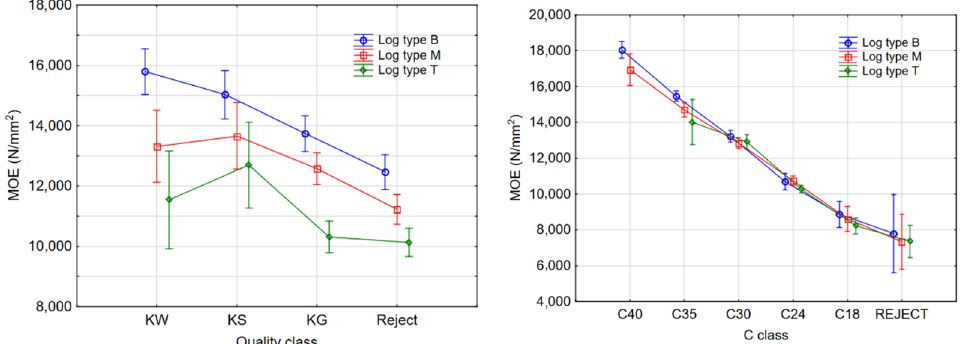
Figure 5. MOE distribution in relation to timber quality.